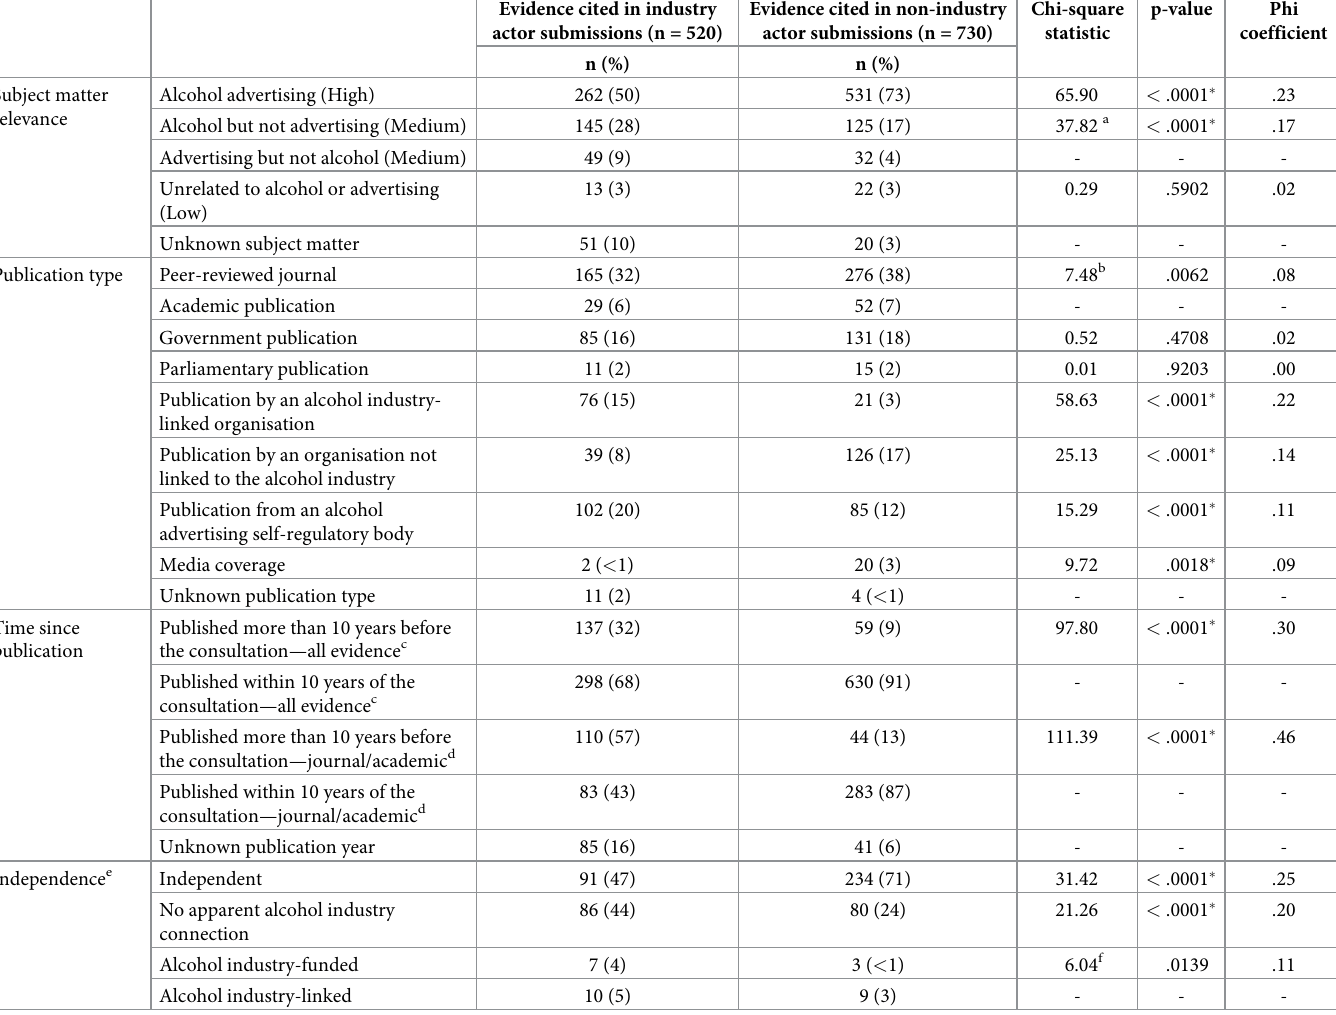
Table 3. Comparisons of subject matter relevance, publication type, time since publication, and